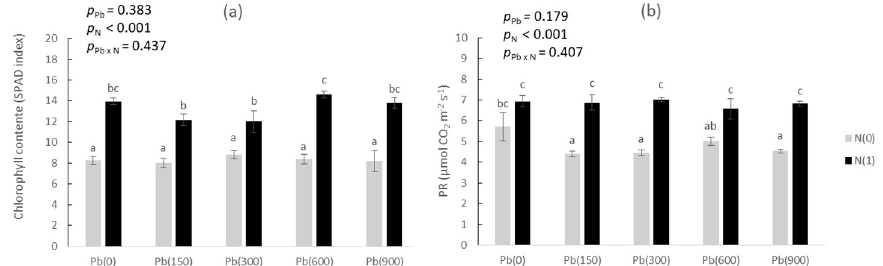
Figure 2. ( a ) Chlorophyll content index (OPTI) and ( b ) photosynthetic rate (LICOR) in purslane as affected by the addition of Pb (0, 150, 300, 600, and 900 mg kg − 1 soil) and with (N1) and without added nitrogen (N0). Different letters above each bar denote significantly different treatments at p < 0.05.